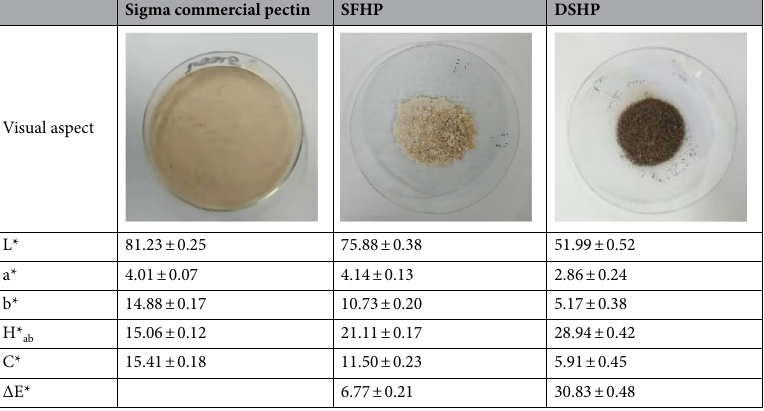
Table 2. Color parameters (L * , a * , b * , ΔE, H * ab , C * (lightness, redness, yellowness, total color difference, hue angle, and chroma, respectively)) and visual aspect (pictures) of different pectin power.